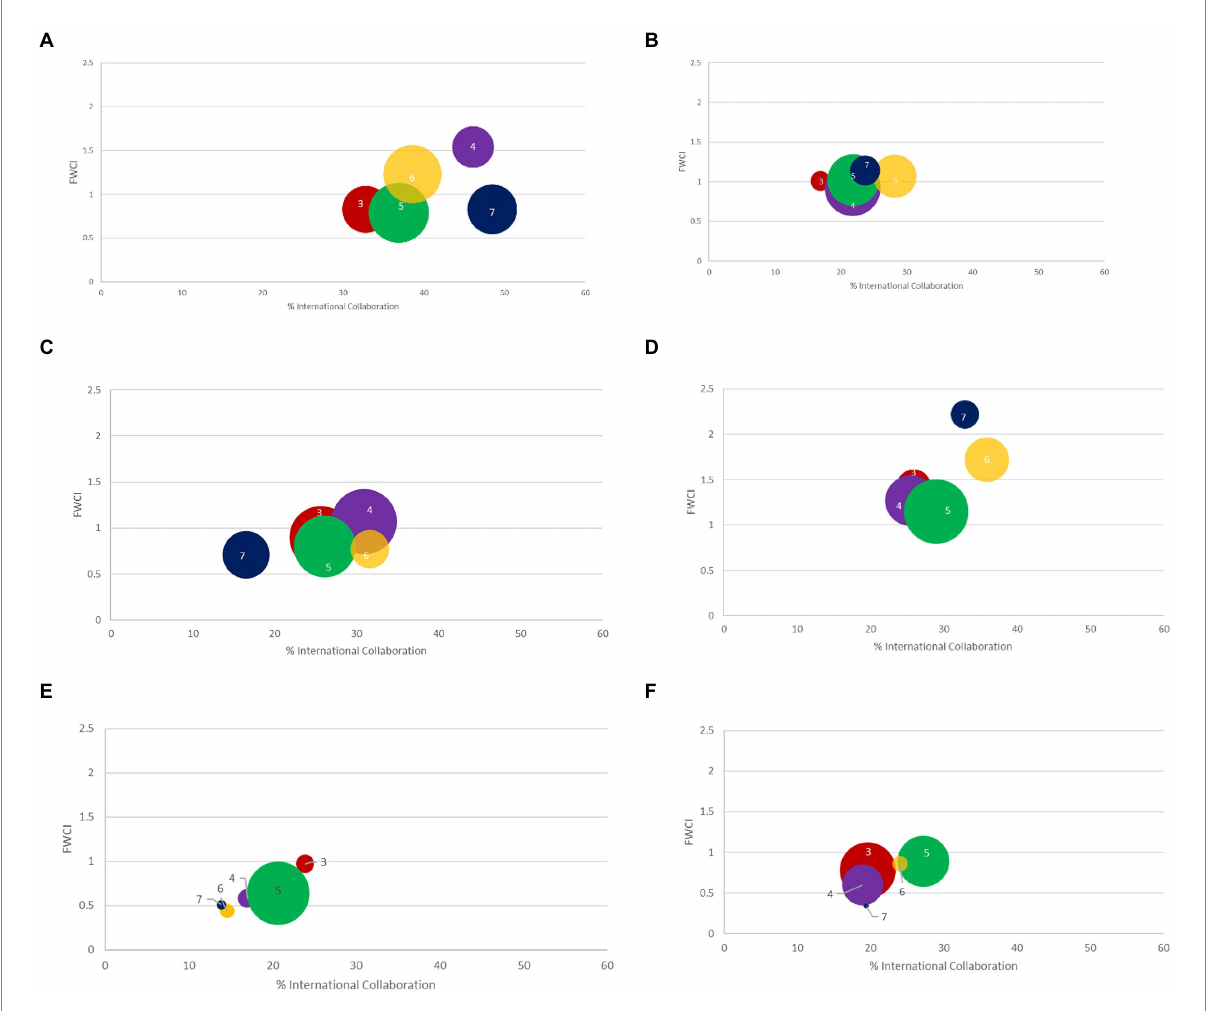
FIGURE 3 Relation between the percentage international collaboration and Field Weighted Citation Impact (FWCI) by program score (ranging 3–7) in six CAPES evaluation areas (A–F) from different broad areas of knowledge (bubble size indicate the number of documents – SciVal